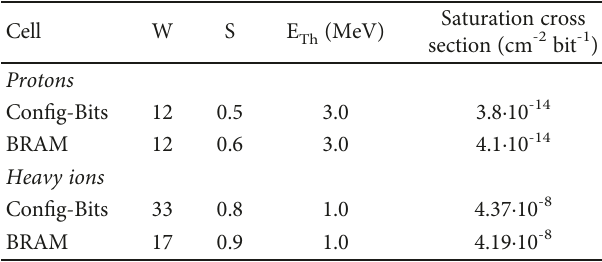
Table 2: Virtex-II irradiation SEU results. Weibull fi tting parameters.